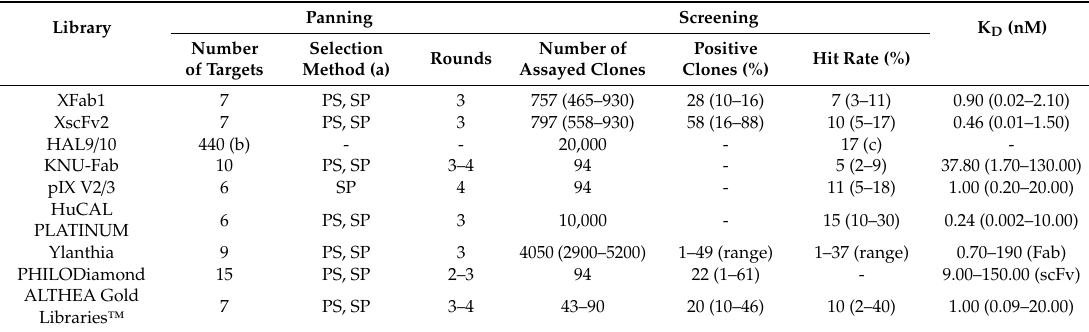
Table 4. Panning and performance of the phage display antibody libraries.